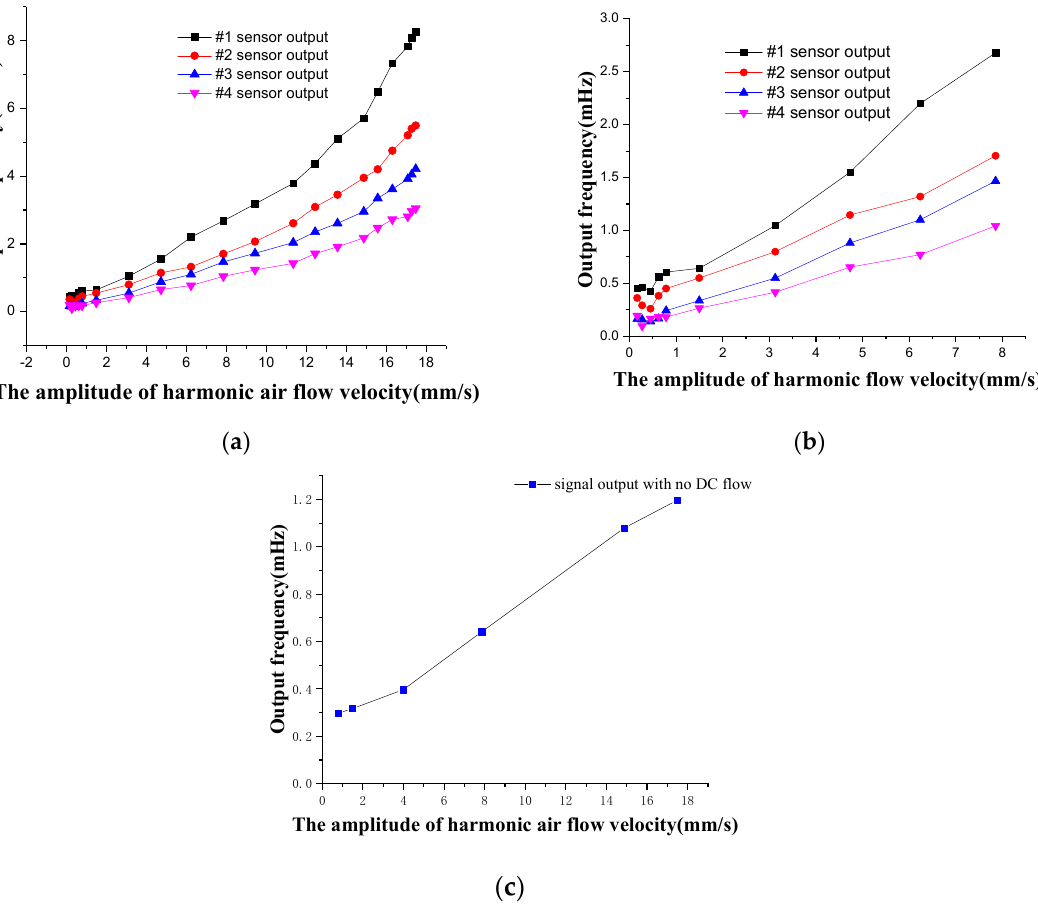
Figure 19. Output frequency response of the oscillatory air flow velocity for artificial lateral line system. ( a ) Output frequency signal of four superficial flow velocity sensors; ( b ) Partial amplification of Figure ( a ) in the oscillatory air flow velocity of 0–8 mm/s; ( c ) Output frequency signal of canal flow velocity sensor.